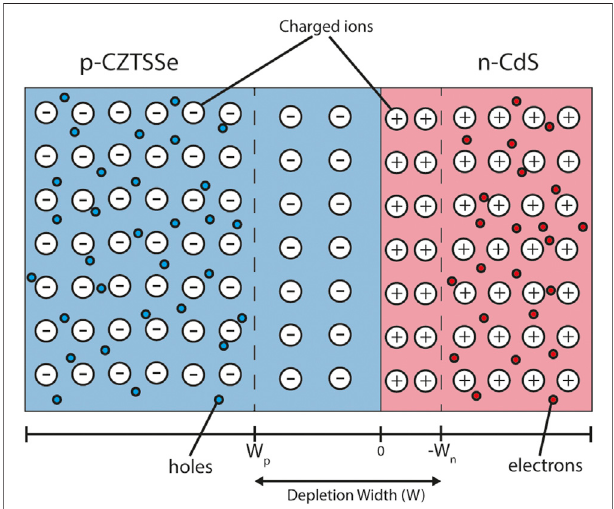
FIGURE 4 | Depletion region schematic of the CZTSSe/CdS junction. The blue and red colouring represent p-type CZTSSe and n-type CdS respectively. The static charged ions — responsible for material doping — are also drawn. The depletion region does not contain any mobile charges. The black bar below denotes the material interface point (0), p-type depletion width ( W p ) and n-type depletion width ( W n ).